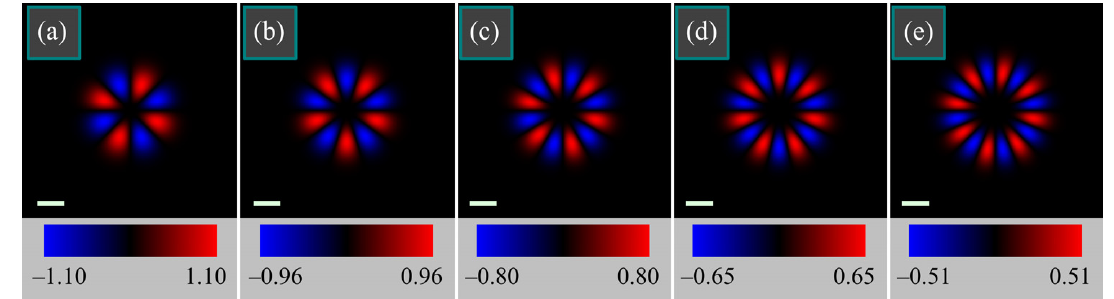
Figure 10. Distributions of the OAM density of the light field (5) at the maximal-SAM distance (33) for the following parameters: wavelength λ = 532 nm, Gaussian beam waist radius w 0 = 1 mm, number of the polarization singularities in the initial plane m = 4 ( a ), m = 5 ( b ), m = 6 ( c ), m = 7 ( d ), m = 8 ( e ), radius of the singularities circle a 0 = 1052 μ m ( a ), a 0 = 1141 μ m ( b ), a 0 = 1223 μ m ( c ), a 0 = 1300 μ m ( d ), a 0 = 1371 μ m ( e ), propagation distance is z = 0.349 z 0 ( a ), z = 0.284 z 0 ( b ), z = 0.240 z 0 ( c ), z = 0.208 z 0 ( d ), z = 0.183 z 0 ( e ). The radii a 0 were computed by Equation (34) to maximize the SAM (and thus the OAM) over all other radii a 0 . Propagation distances were computed by Equation (33) to maximize the SAM (OAM) density. All quantities are given in arbitrary units. Scale mark in each figure denotes 1 mm.